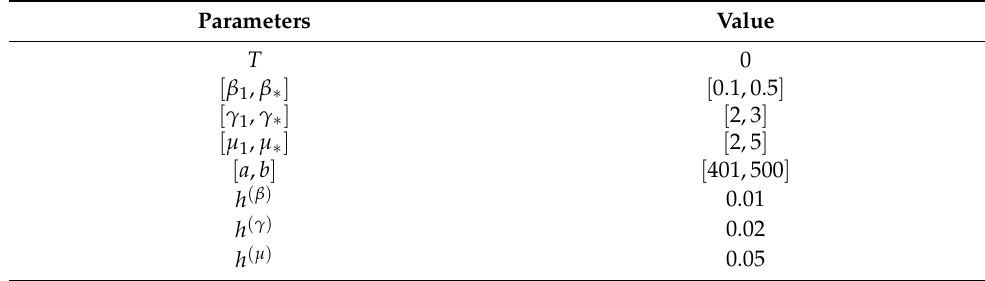
Table 2. The initial values of the model parameters.